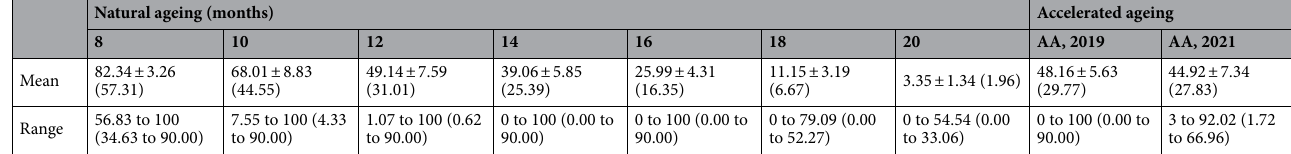
Table 1. Mean and range of seed germination percentage in different soybean genotypes after natural and accelerated ageing. Values in the parenthesis are arcsine transformed germination